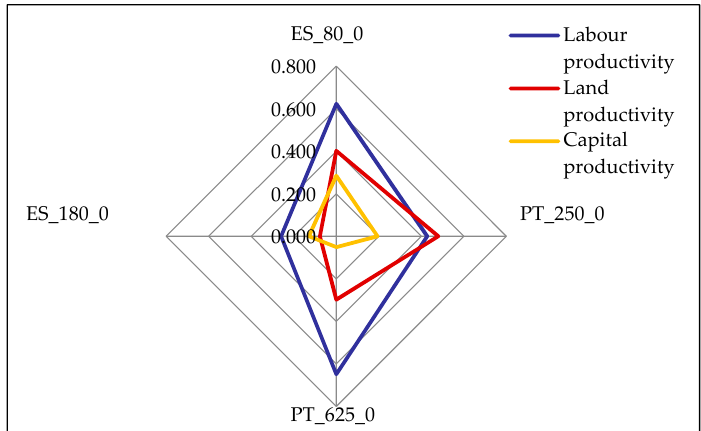
Figure 11. Productivity: Labor (kg LW / h), Land (kg LW / ha) and Capital (kg LW / 1000 € ). Source: model results.